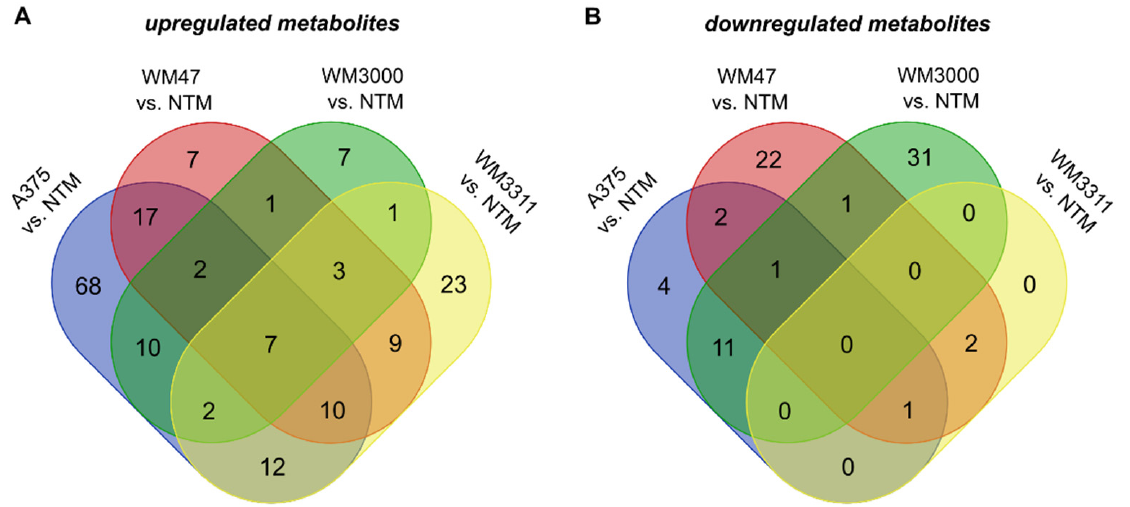
Figure 8. Overlap of plasma metabolites between melanoma-bearing mice and non-tumor mice. The Venn diagram demonstrates the intersections of ( A ) upregulated and ( B ) downregulated plasma metabolites between each type of melanoma xenograft model versus NTM.